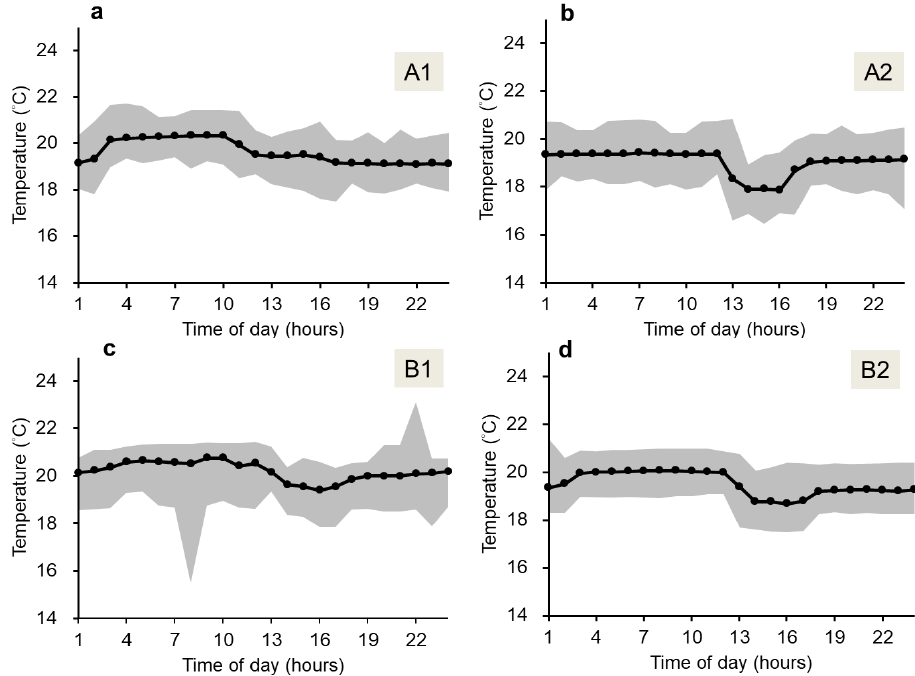
Figure 16. Variation in temperature in cultivation zones ( a ) A1, ( b ) A2, ( c ) B1, and ( d ) B2.